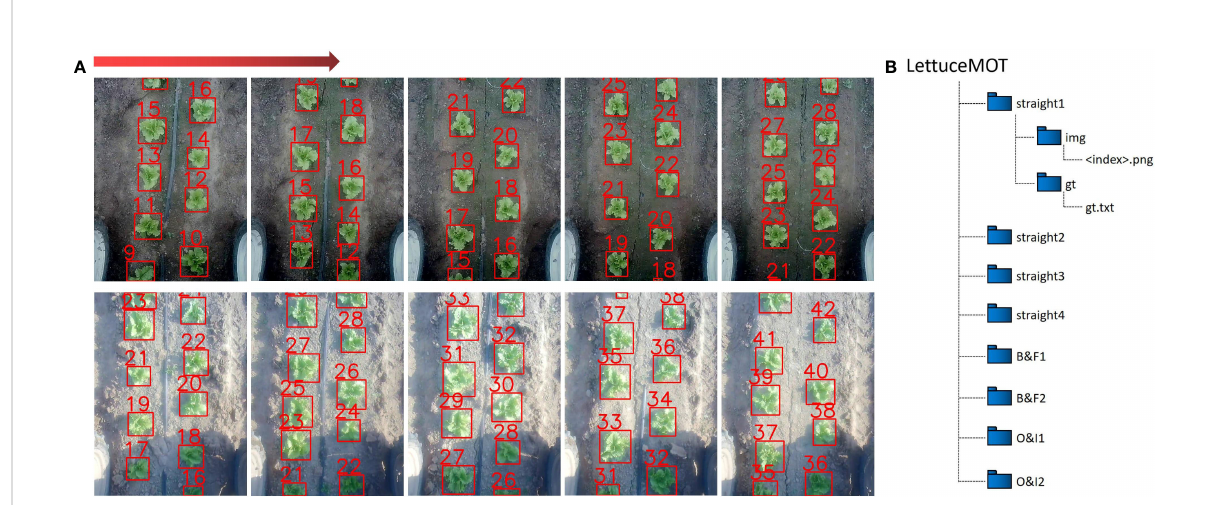
FIGURE 2 Details of the dataset. (A) Sample images and their corresponding annotations. The direction of the red arrow indicates the order of images. (B) The fi le structure of the